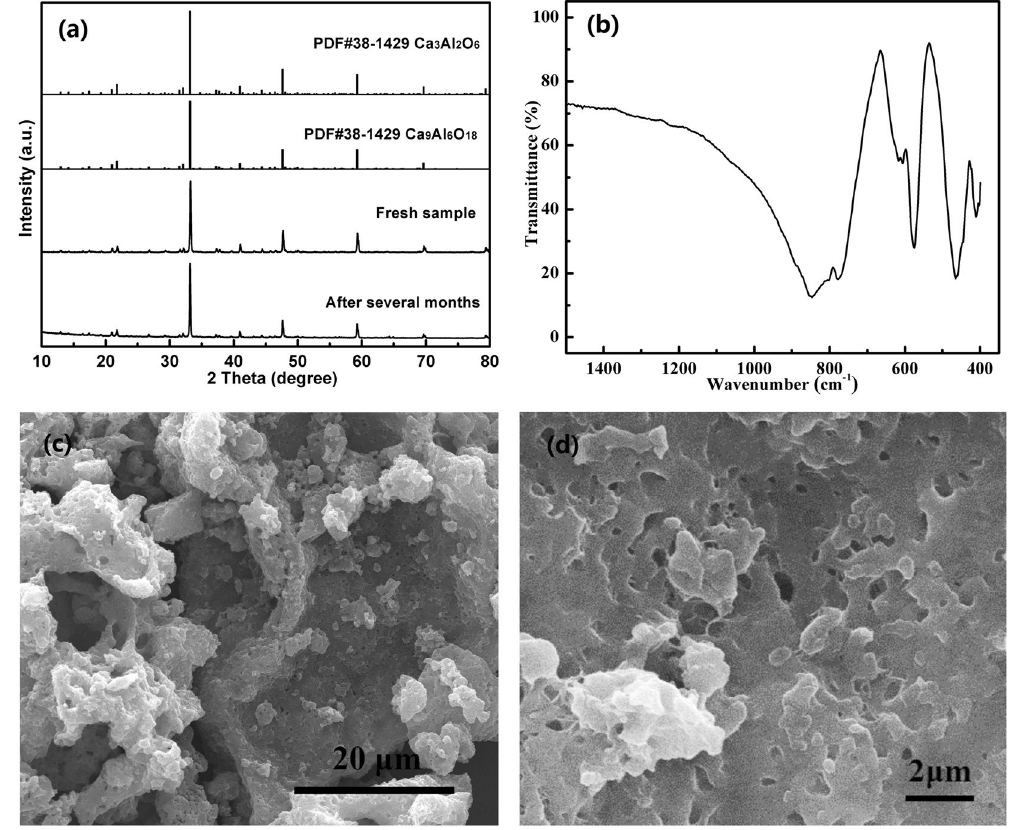
Figure 1. XRD pattern ( a ), FT-IR spectrum ( b ), SEM images ( c , d ) of the as-prepared Eu-doped calcium